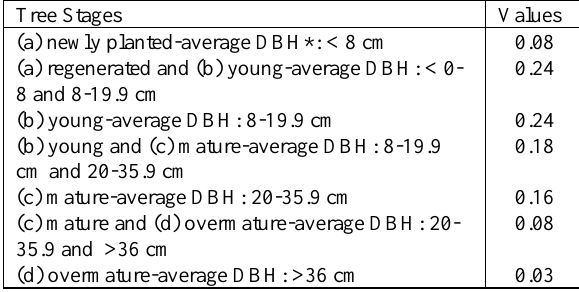
Table 12. The weighted values of tree stages The weighted values of ground slope criteria (and sub-criteria) were indicated in Table 13. The steep slope and high slope areas Figure 6. Aspect map had the highest weighted values. For the aspect criterion, south and southwest aspects had the highest weighted values, while north aspect had the lowest (Table 14).